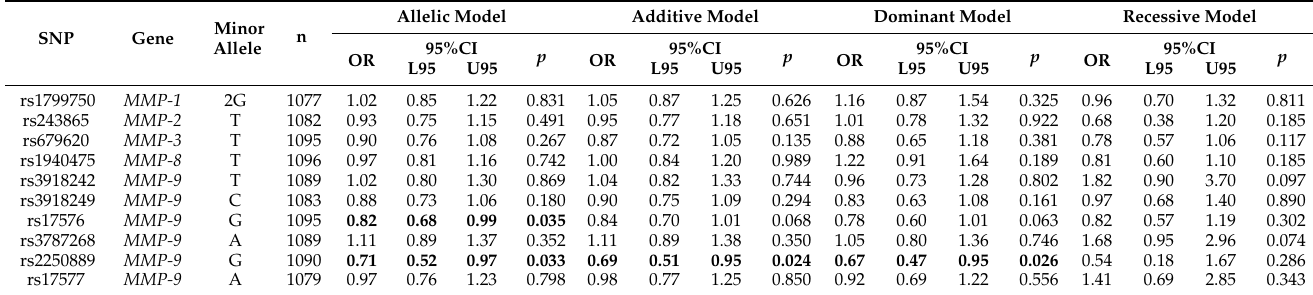
Table 2. Associations of the studied gene polymorphisms with breast